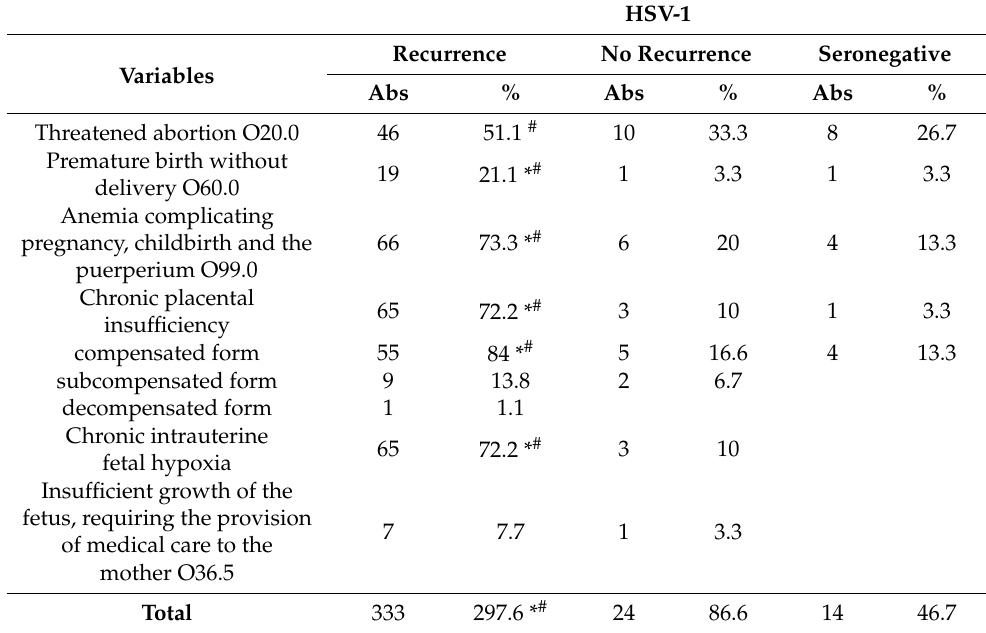
Table 7. The frequency and structure of pregnancy complications in the study groups.